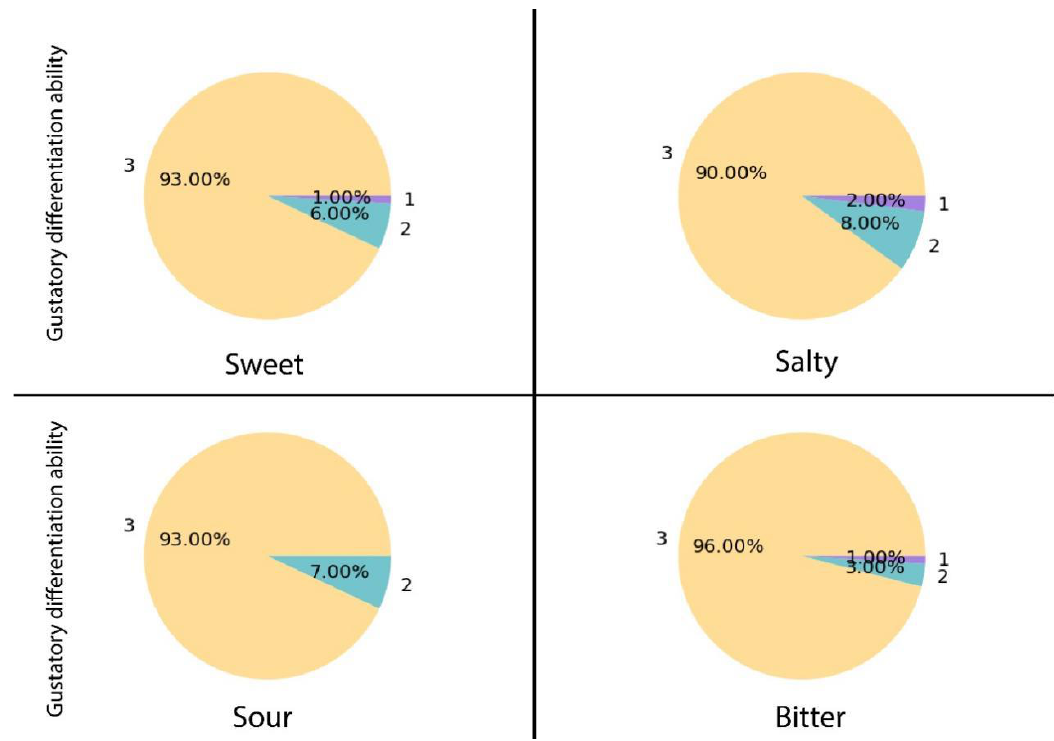
Figure A3. The gustatory perception ability among the healthy pretested population.